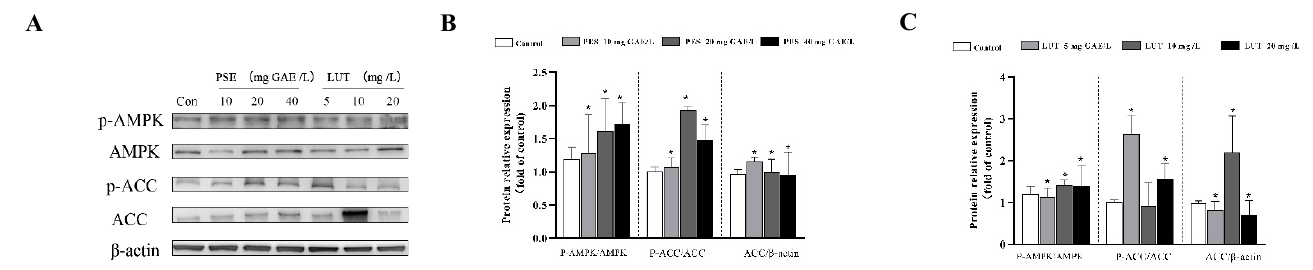
Figure 4. PSE and LUT modulated the expression of the phosphorylation of AMPK and ACC in the 3T3 － L1 adipocytes. ( A ) Western blot results for the phosphorylation of ACC and AMPK. Quanti- fication of pACC/ACC, pAMPK/AMPK, and ACC/ β － actin after ( B ) PSE and ( C ) LUT treatments. The data are presented as the mean ± SD from three independent experiments. * Significant differences are indicated by p < 0.05.